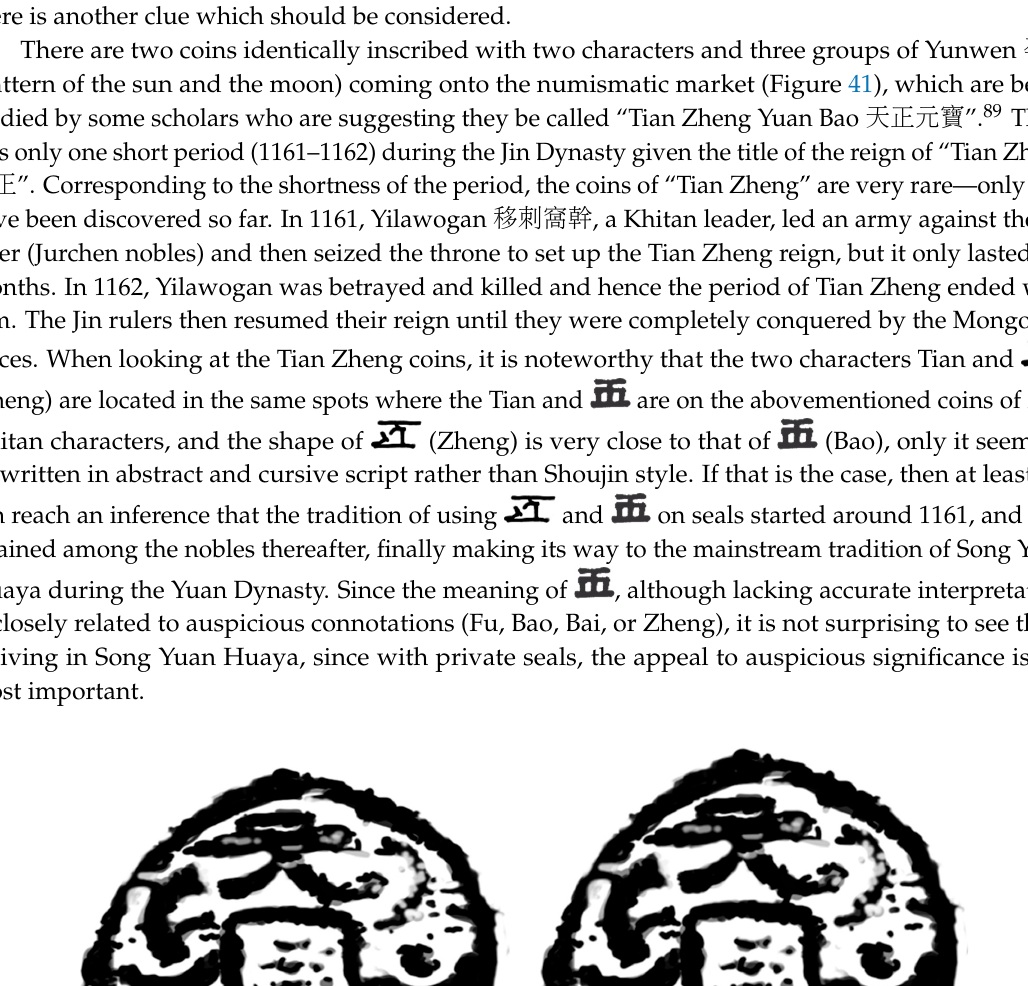
Figure 36. A Khitan coin inscribed with four characters. The Liao Dynasty. Sketched by author. Picture source: Wei (1984), p. 62.